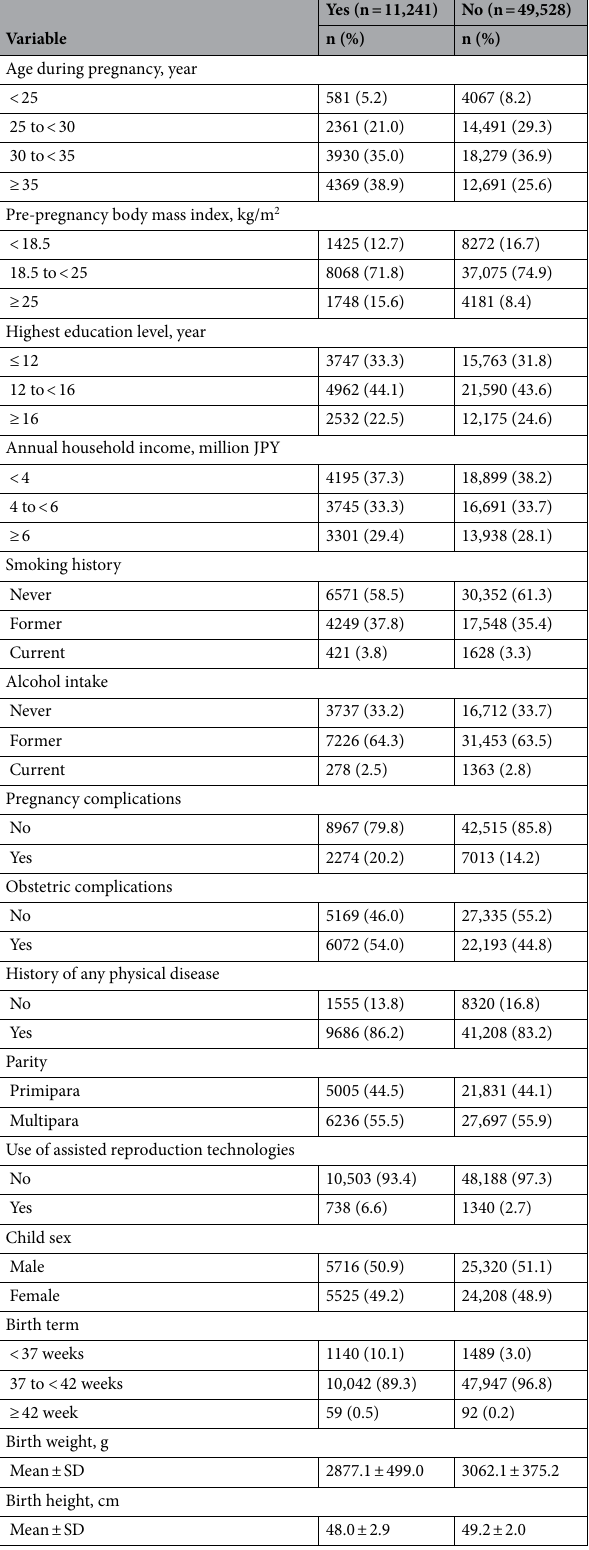
Table 1. Characteristics of the study population. ART assisted reproductive technology, BMI body mass index (calculated as kg/m 2 ), SD standard